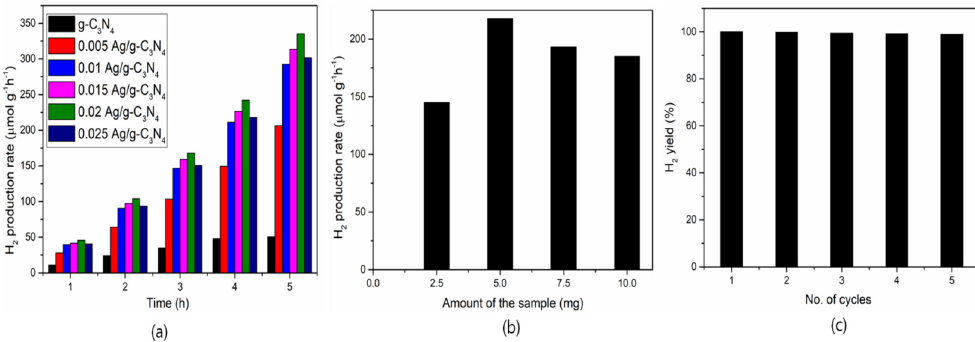
Figure 9. ( a ) Hydrogen production rate with the function of time for the pure g-C 3 N 4 and Ag-anchored g-C 3 N 4 ; ( b ) Amount of hydrogen production with different amounts of catalyst, and ( c ) reusability of catalyst.